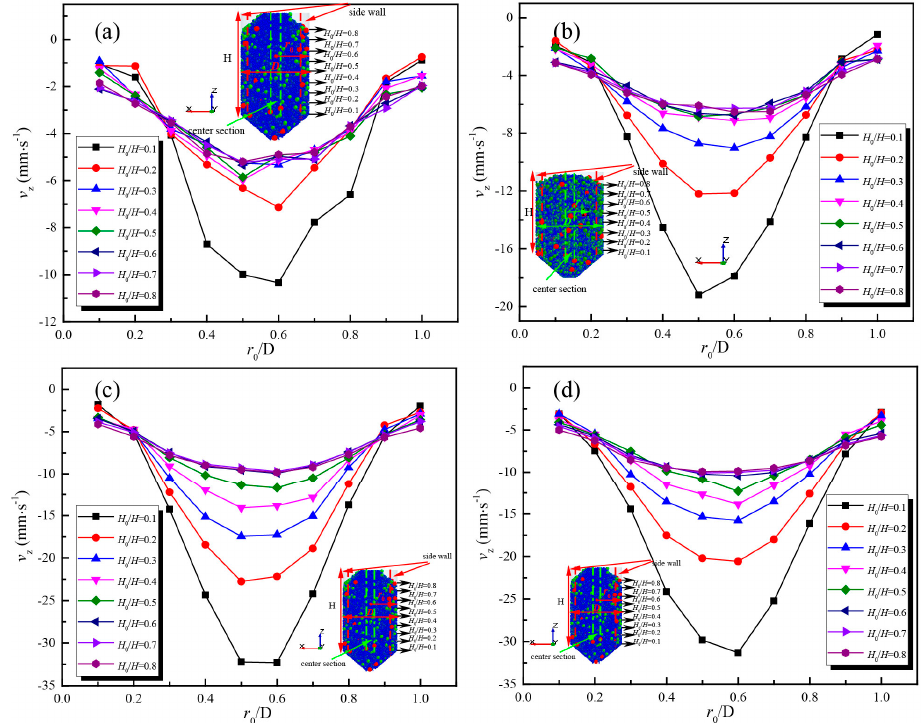
Figure 28. The variation in velocity of all sinter layers for different discharge velocities of outlets of ( a ) v a = 0.1 m ∙ s − 1 , ( b ) v a = 0.2 m ∙ s − 1 , ( c ) v a = 0.3 m ∙ s − 1 , and ( d ) v a = 0.4 m ∙ s − 1.